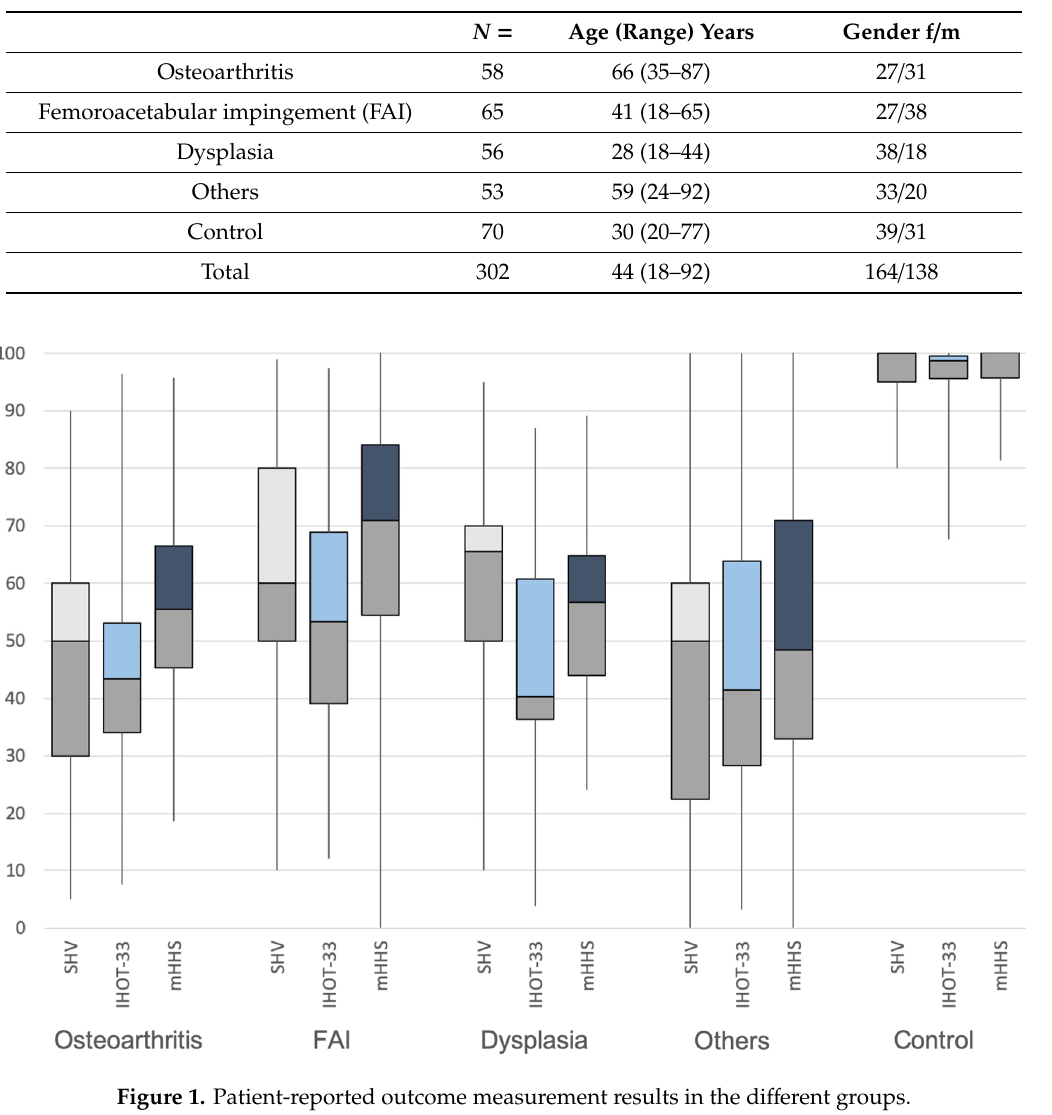
Table 2. Correlation coefficients ( r ) and r 2 of the subjective hip value (SHV) with the modified Harris hip score (mHHS) and the International Hip Outcome Tool (iHOT-33).